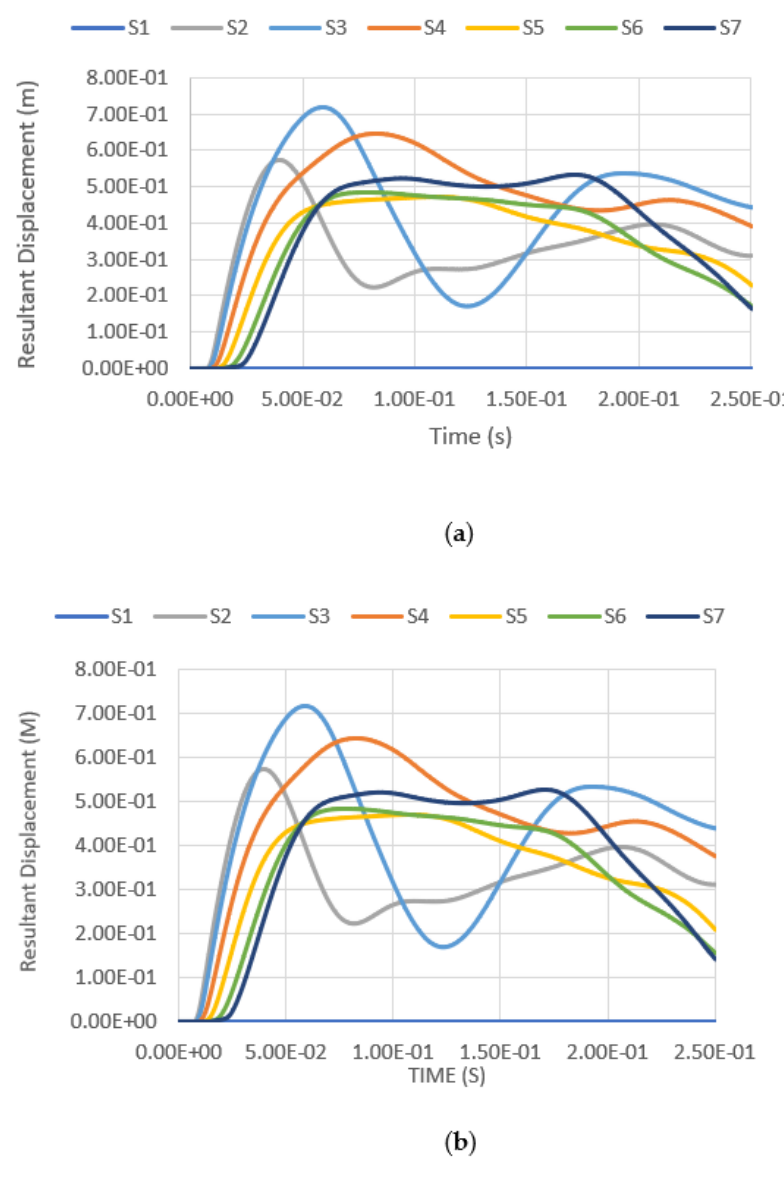
Figure 14. Resultant displacement versus time under blast intensity of 1500 kg TNT equivalent mass 12.5 m away, ( a ) 100% fill and ( b ) 0% fill.